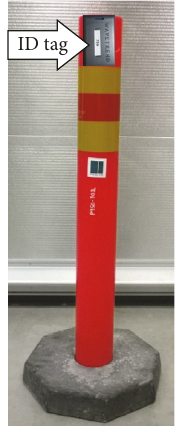
Figure 7: Safety cone.